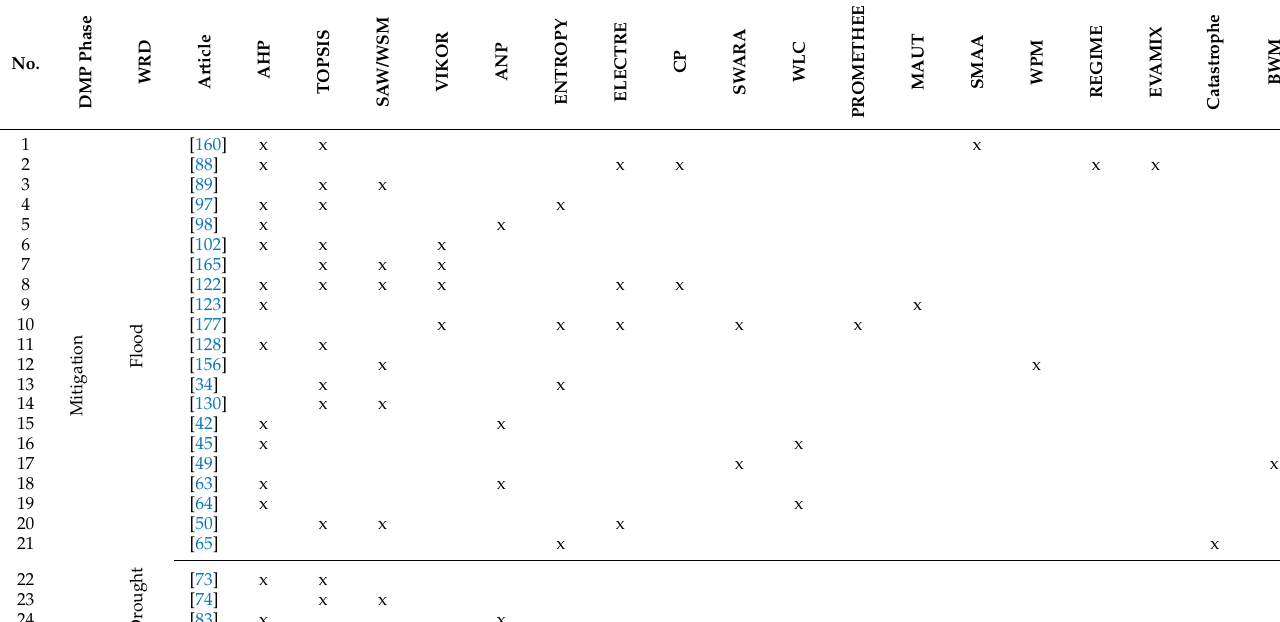
Table 11. Application of mixed-method techniques in the mitigation phase.